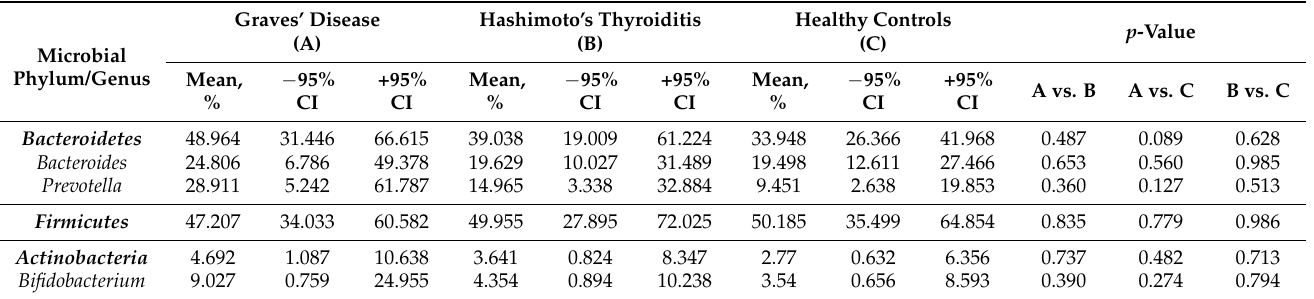
Table 4. Pooled relative abundance (%) for the most common microbiota in autoimmune thyroid disease patients.